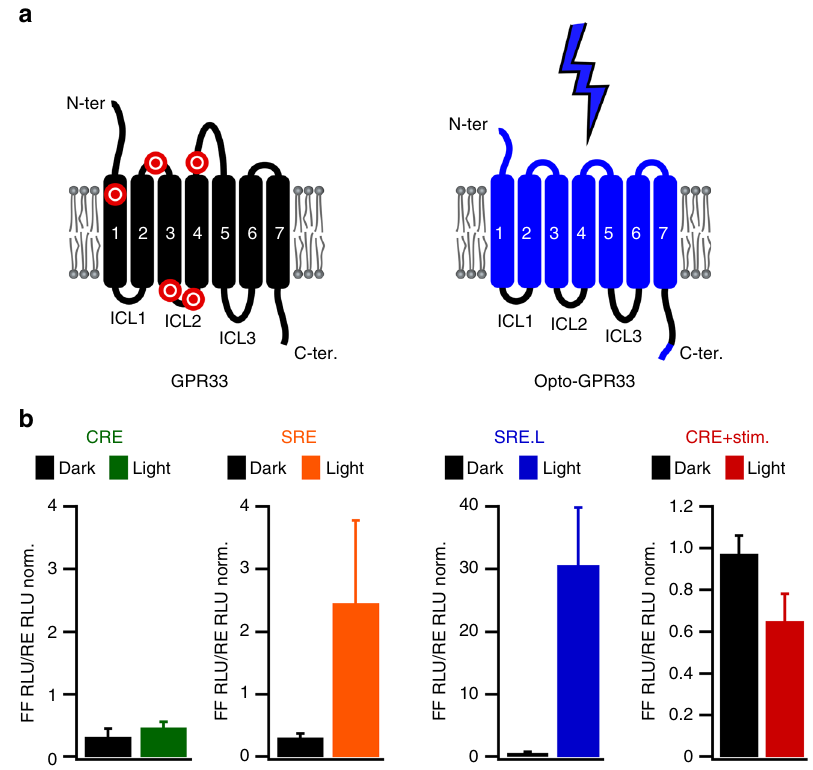
Fig. 4 Optical resurrection of GPR33. a Left: In rodent and hominoid species, the chemokine-like receptor GPR33 is inactivated by stop codons. Red markers: approximate positions of stop codons in the pseudogenized mammalian GPR33 coding sequences. Right: Light-activated variant of the human ancestral GPR33 receptor. b Reporter activation by Opto-GPR33 upon light stimulation. Mean values ± s.e.m. ( n = 6 – 8 wells, 3 – 4 independent experiments) are